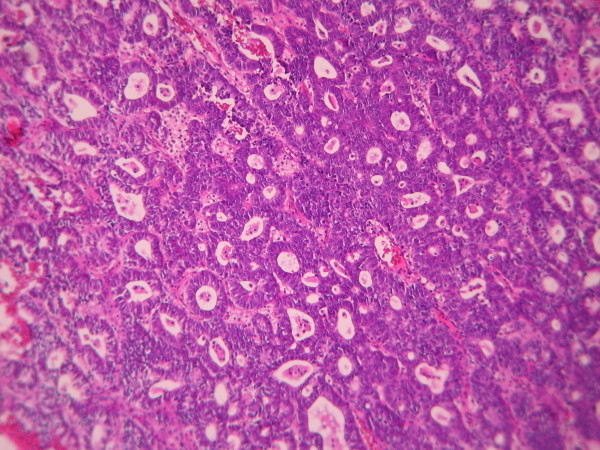
Endometrial adenocarcinoma. Closely back to back glands without intervening endometrial stroma and with granulation tissue like stroma and cribriform pattern. (Low power).